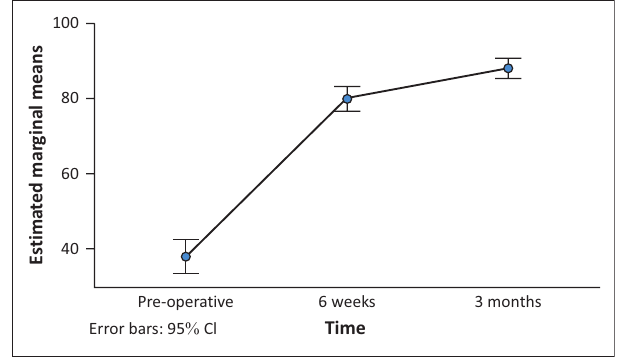
FIGURE 1: Western Ontario and McMaster Universities Osteoarthritis index mean total score over time with 95% confidence interval in treatment